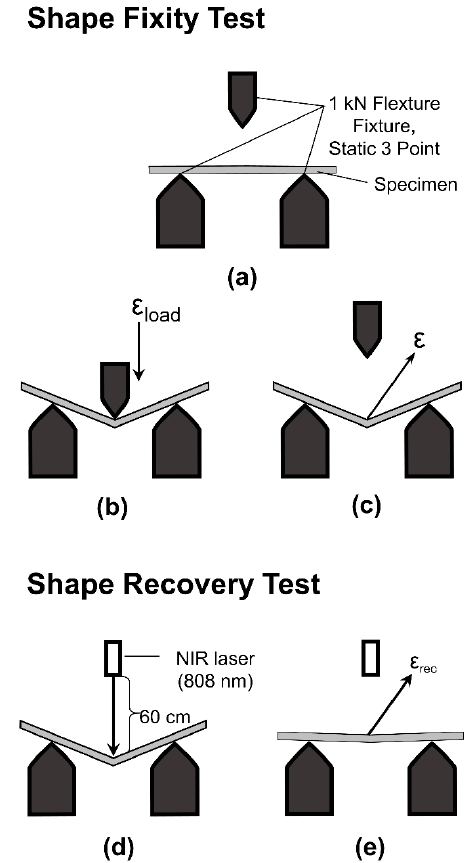
Figure 1. Experimental procedures for the shape fixity test ( a – c ) and the shape recovery test ( d , e ).